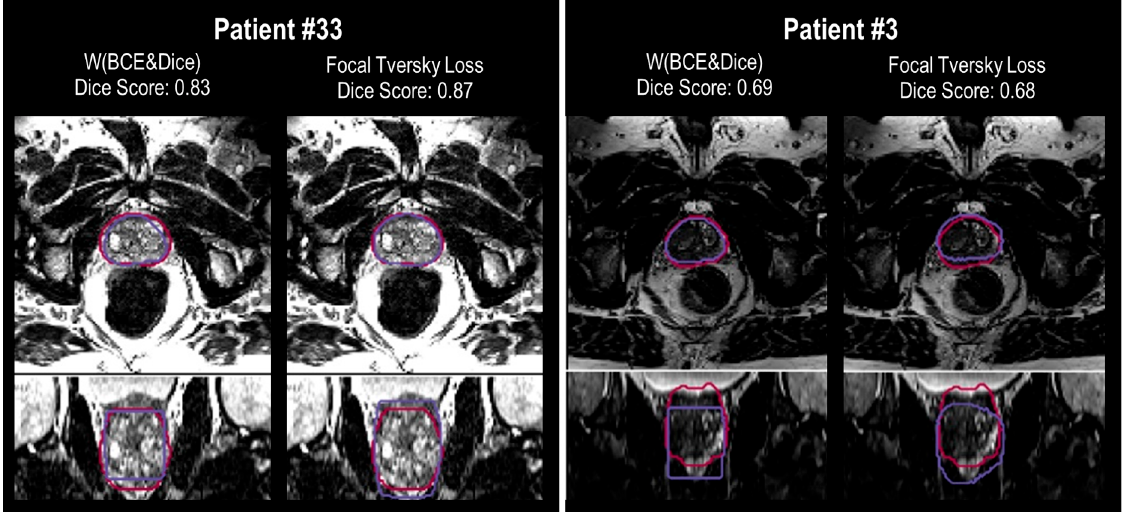
Figure 8. Outputs of two models (Focal Tversky and W (BCE + Dice)) in the axial (top image) and coronal views (bottom image for each patient), demonstrating both high and low performances, measured in Dice scores. The ground truth is represented by the red contour, the model’s prediction contour is shown in purple.